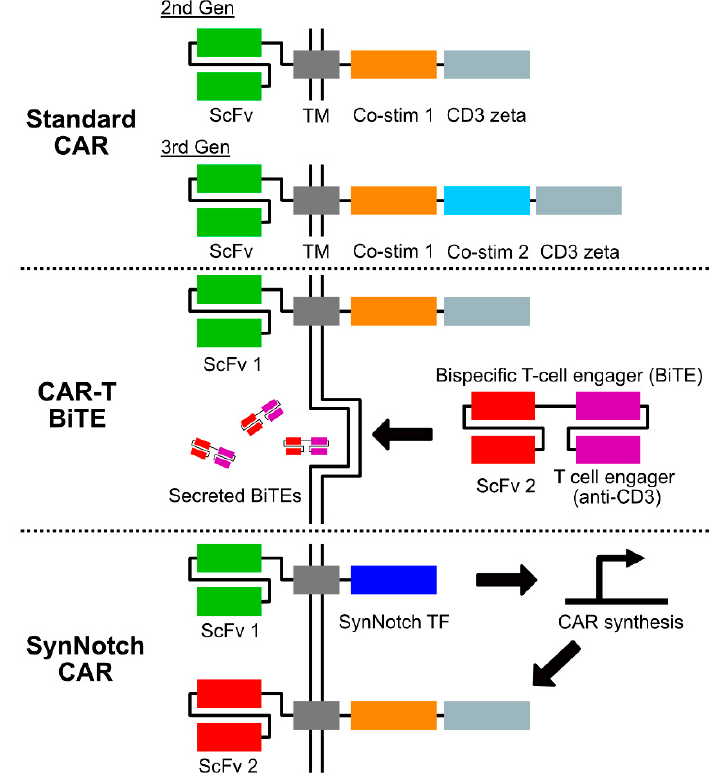
Figure 1. Chimeric antigen receptor (CAR) construct strategies under investigation in gliomas. Standard CAR designs under clinical investigation in GBM include both second and third generation constructs, which differ in the number of intracellular costimulatory domains. Multiple costimulatory domains are currently under investigation, with CD28 and 4-1BB most commonly used to date [6]. Combined CAR-T and bispecific T-cell engager (BiTE) constructs are an emerging strategy in which T-cells are engineered to express both a CAR and a secreted bispecific molecule with specificity to both a second tumor-targeting antigen and a surface T-cell molecule such as CD3 [9]. SynNotch CARs function as a synthetic logical AND gate [10]. Engagement of a tumor antigen target induces intracellular T-cell signaling via a synthetic Notch construct. This “priming” step induces the synthesis of a standard CAR molecule, which when expressed on the T-cell surface enables cytotoxic